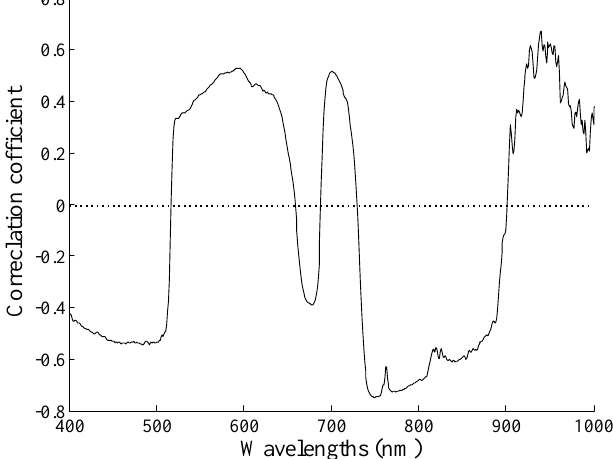
Figure 5. Correlation curve between growths stages and reflectance spectra.